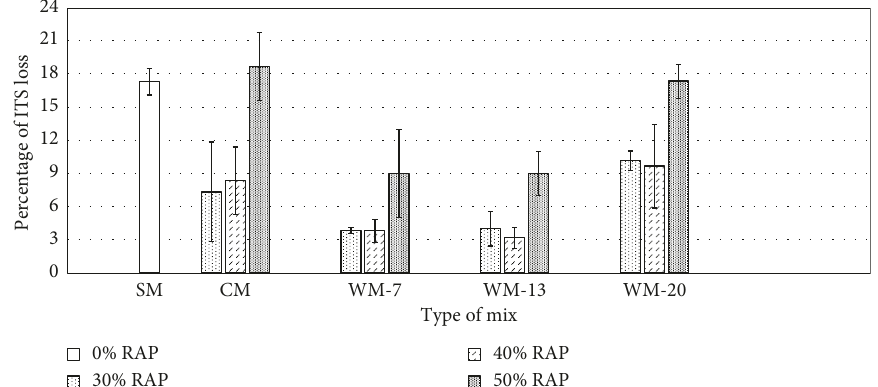
Figure 5: Comparison of ITS loss for mixes with no RAP and rejuvenated by CR with mixes rejuvenated by